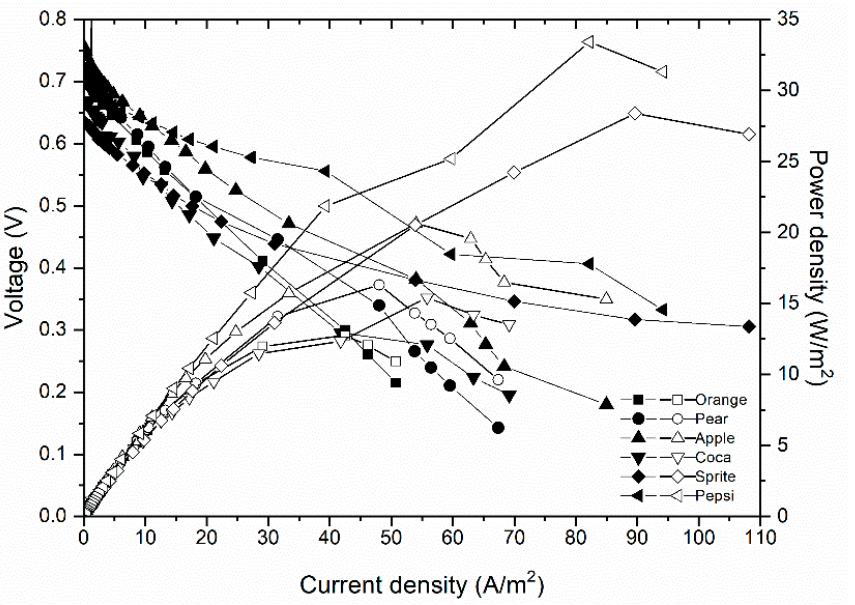
Figure 5. Power density and cell voltage curves of the alkaline fuel cell filled with different sweet drinks.